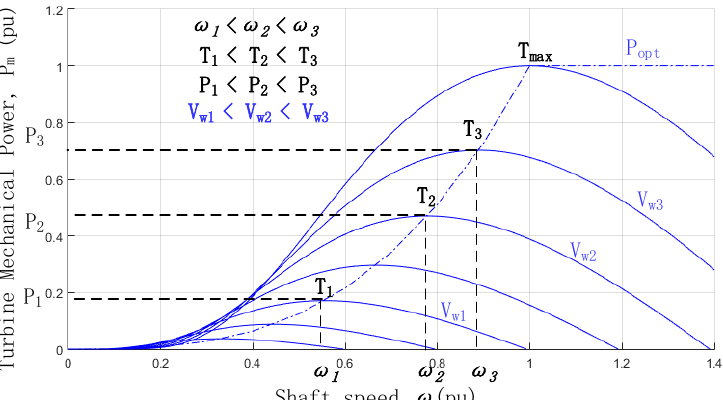
Figure 6. Power captured in different rotating speeds and wind speeds.